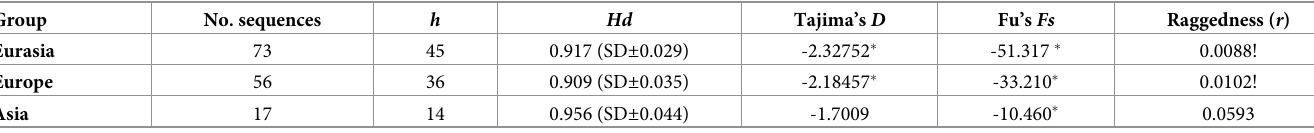
Table 3. Neutrality and mismatch tests across major population groupings of Echinostoma revolutum ( s . s .) from Eurasia. Group No.